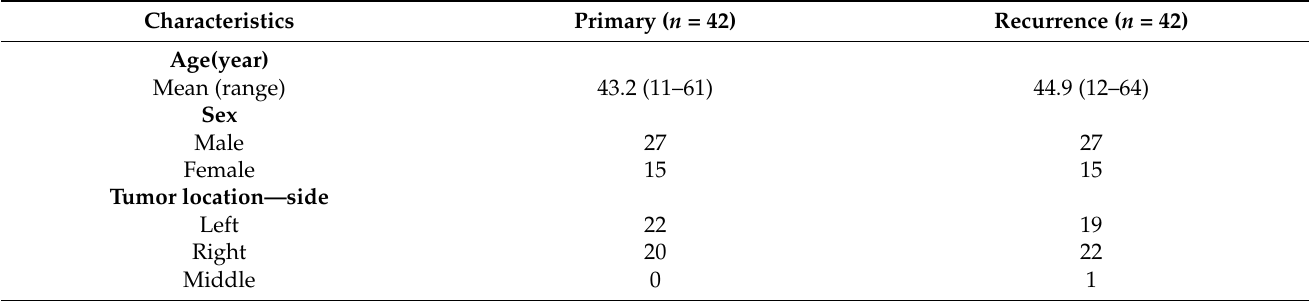
Figure 1. Study profile. Patients with high-quality primary and paired recurrent glioma samples were included. Table 1. Baseline clinical